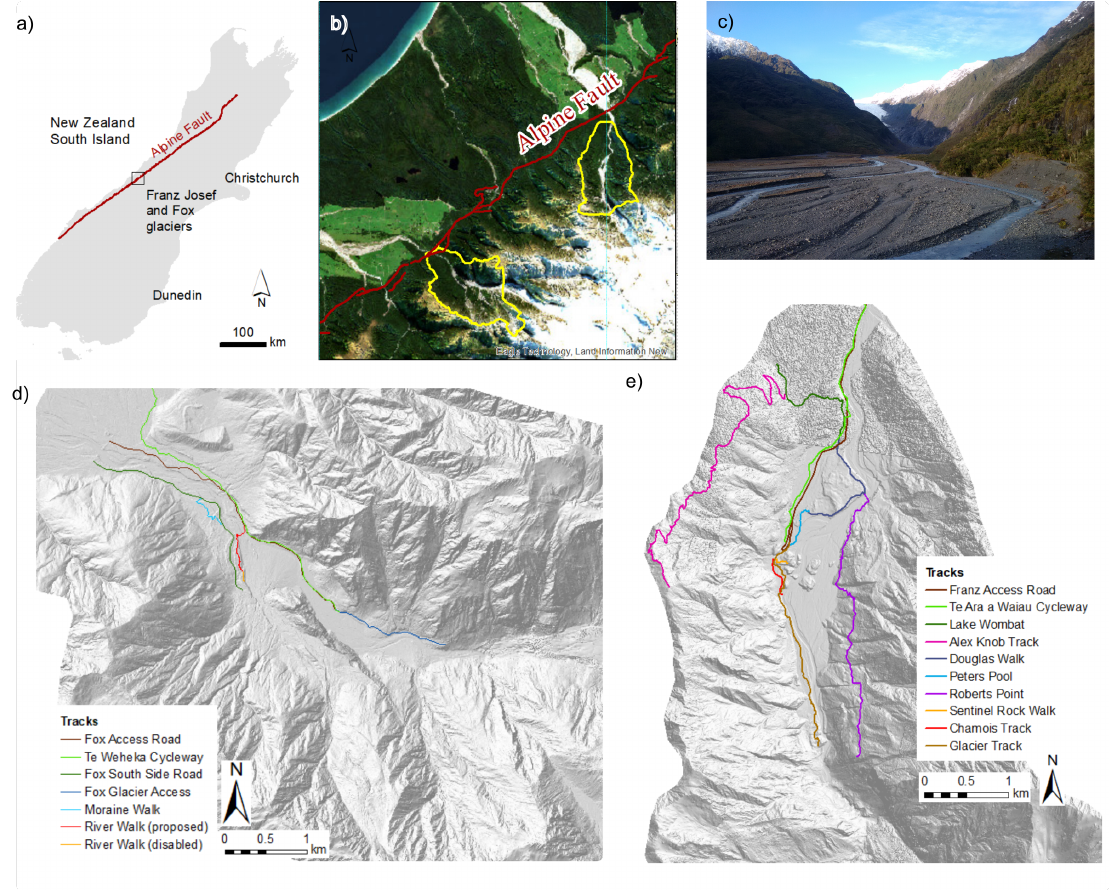
Figure 1. Location of the Franz Josef Glacier and Fox Glacier valleys on the west coast of the South Island (a, b) , which contains data sourced from the LINZ Data Service and licensed for reuse under the CC BY 4.0 licence. (c) Photograph of the Franz Josef Glacier valley. (d) The Fox Glacier valley, including the access roads, cycleway, and tracks within it. (e) The Franz Josef Glacier valley, including the access roads, cycleway, and tracks within